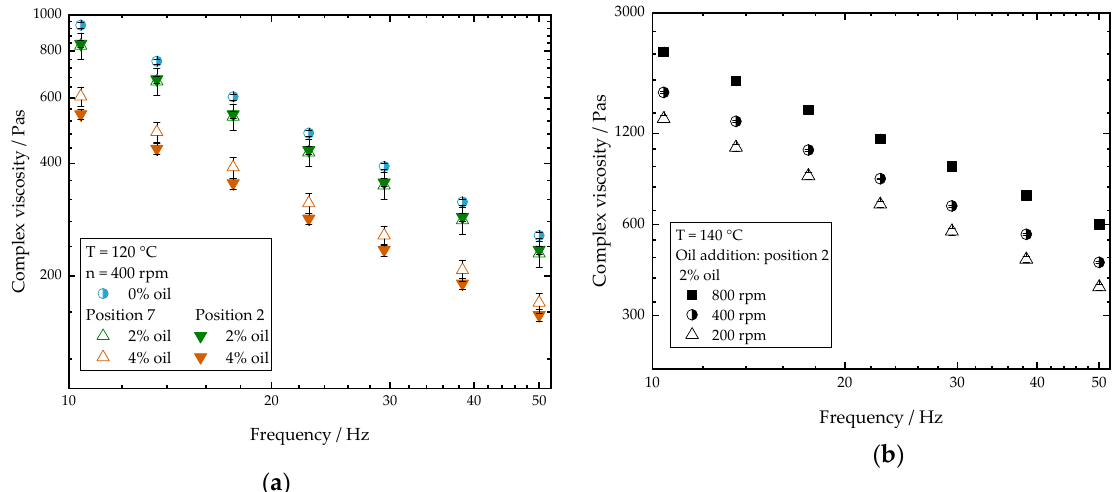
Figure 7. Complex viscosity as a function of the frequency. ( a ) Influence of different oil contents on the complex viscosity as a function of the oil addition point. Position 7 corresponds to open symbols; position 2 corresponds to filled symbols. ( b ) Effect of screw speed on the complex viscosity. Total mass flow was 10 kg/h and water content was 51–53% for all samples.